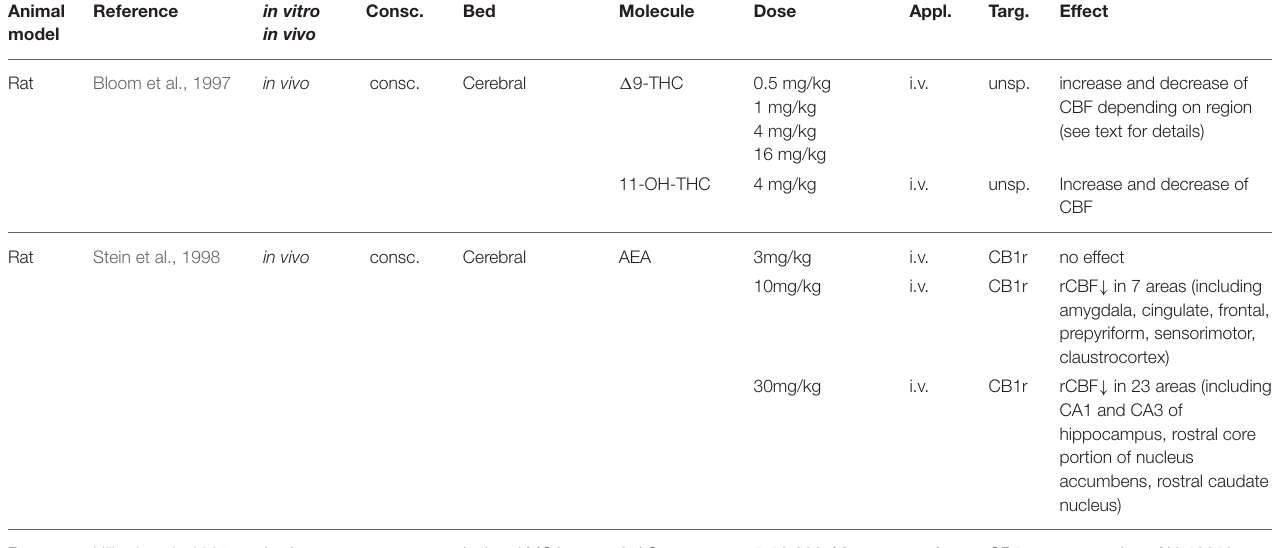
TABLE 1 | Cannabinoid’s vascular effects in animal models specifically targeting cerebral vessels. Animal